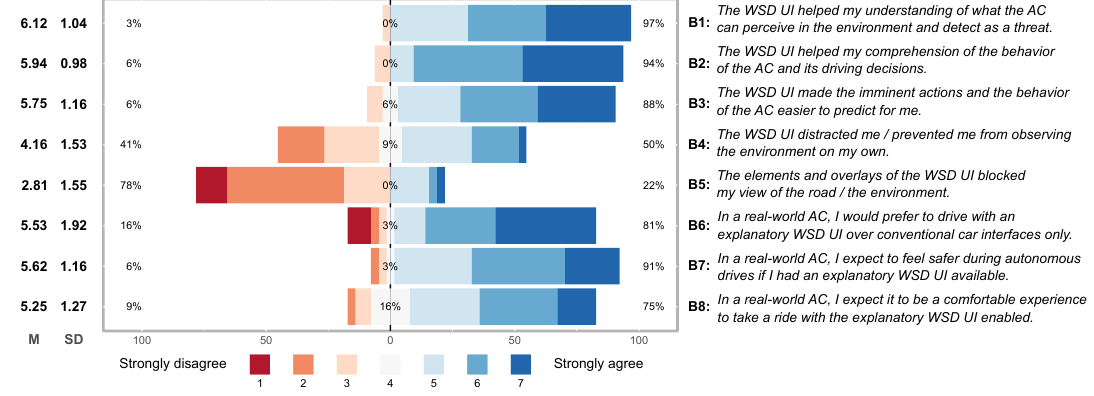
Figure 11. Results for the post-test questionnaire items (statements shortened in figure), which targeted general opinions and user experience regarding the WSD UI after executing all of the study